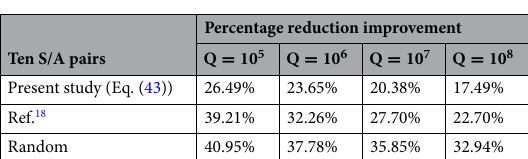
Table 5. Percentage reduction improvement for present study (Eq. (46)) than each case.